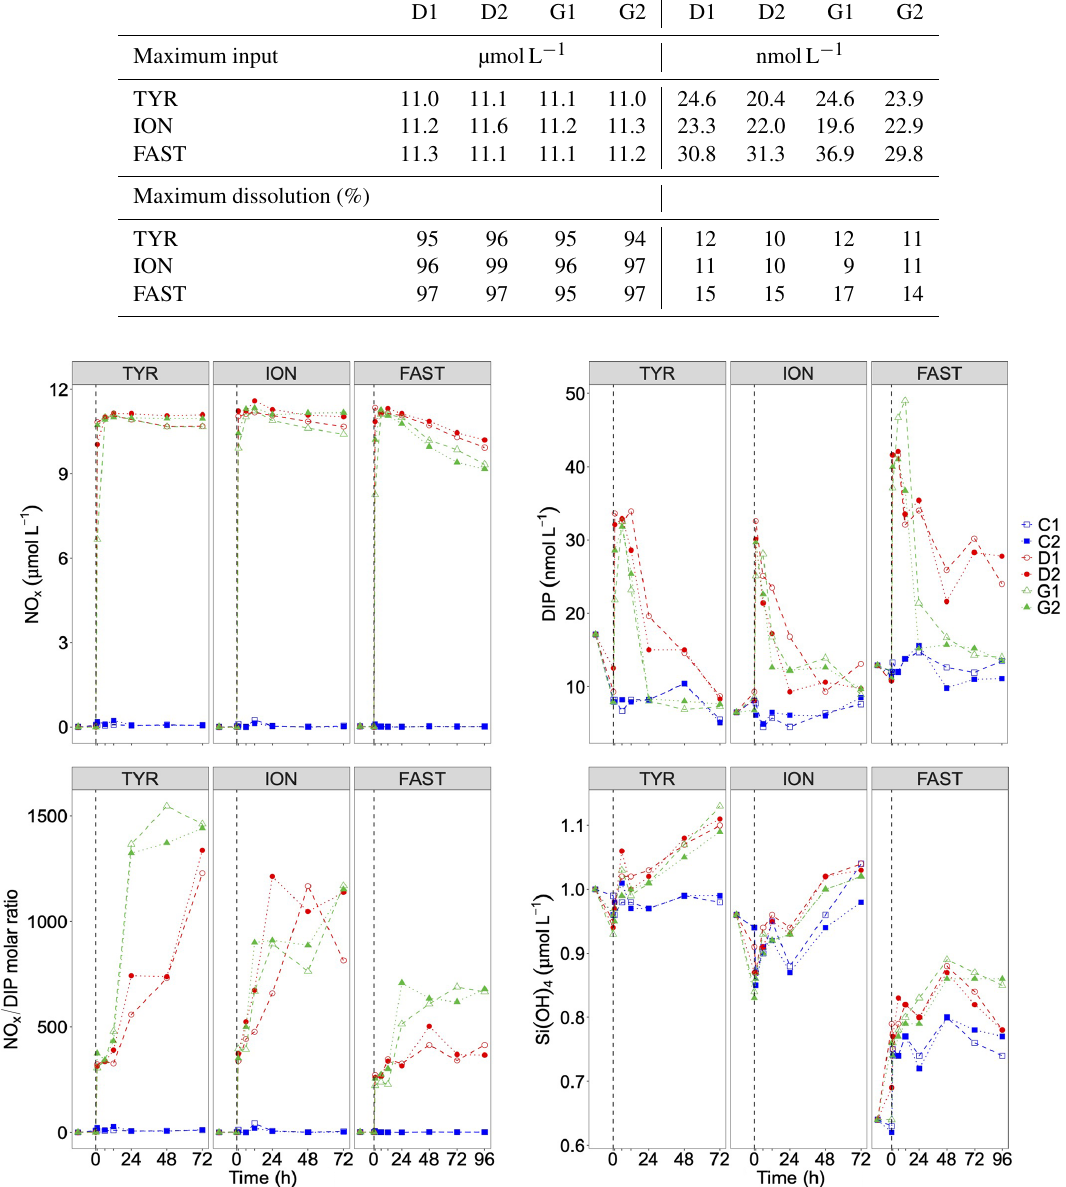
Figure 6. Nutrients (nitrate + nitrite): NO x , dissolved inorganic phosphorus: DIP, silicate: Si(OH) 4 and the molar ratio between NO x and DIP, measured in each tank during the experiments at TYR, ION and FAST. The dashed vertical line indicates the time of seeding (after t0).